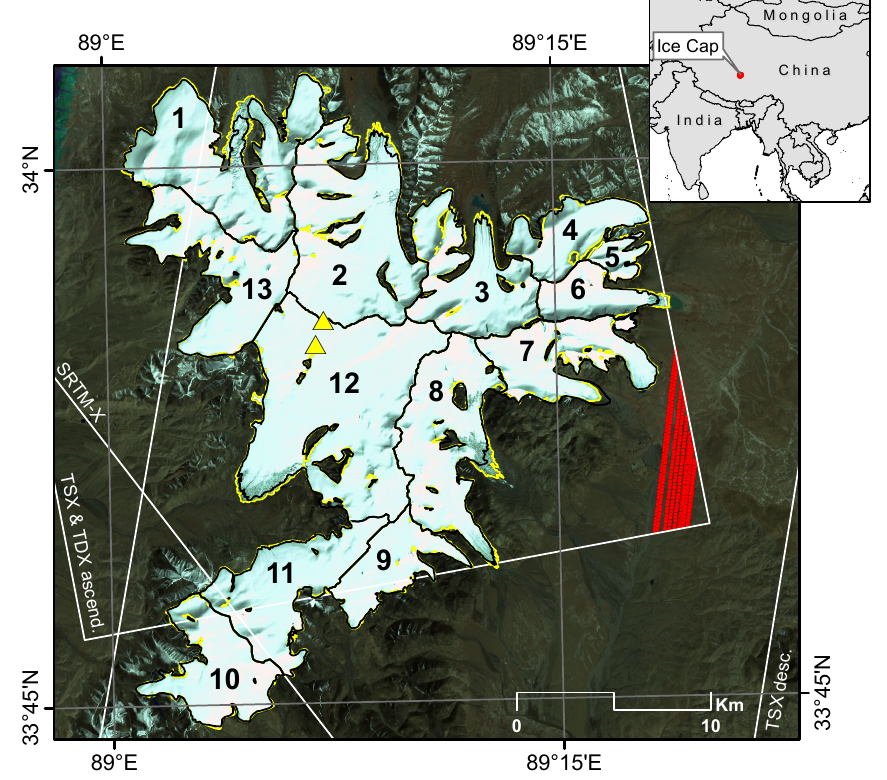
Fig. 1. Landsat ETM+ image, acquired on 7 October 2000, of the Purogangri Ice Cap (PIC) overlayed by SAR image footprints and glacier outlines for the years 2000 (yellow) and 2012 (black). Bands 4, 3, and 2 are combined as red, green, and blue, respectively. ICESat footprints are indicated as small red dots. Ice core drill sites of the Byrd Polar Research Center are shown as yellow